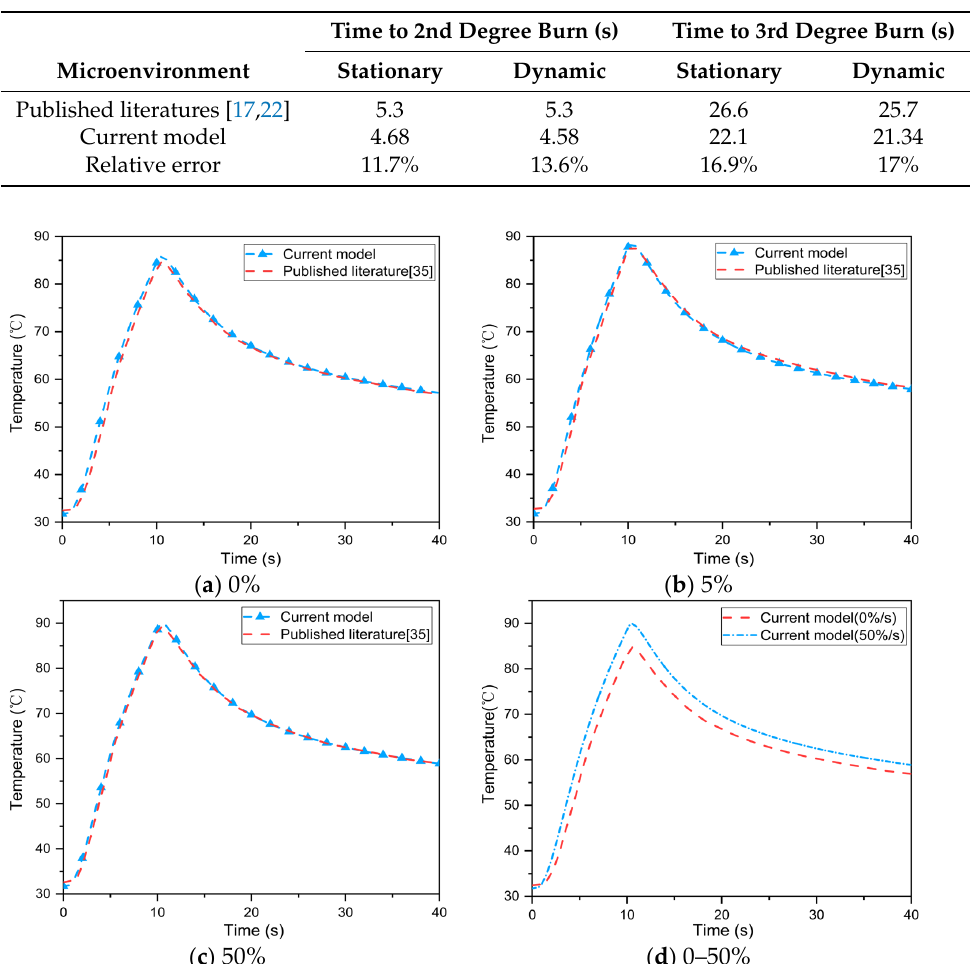
Figure 6. Comparison between the temperature at epidermis–dermis interface predicted by the current model and the published literature [17]. Table 2. Time to 2nd degree and 3rd degree skin burn injuries in both stationary and dynamic microenvironments predicted the current model and models reported in published literature [17,22].